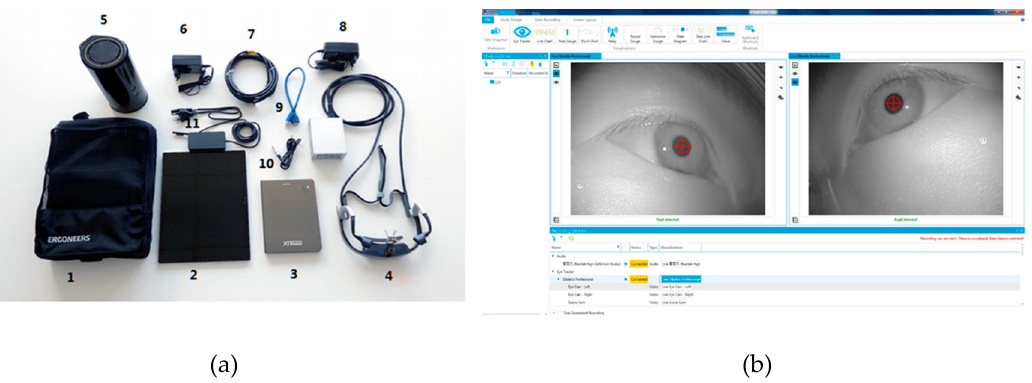
Figure 3. Dikablis Pro eye-tracker ( a ) and D-Lab software user interface ( b ).